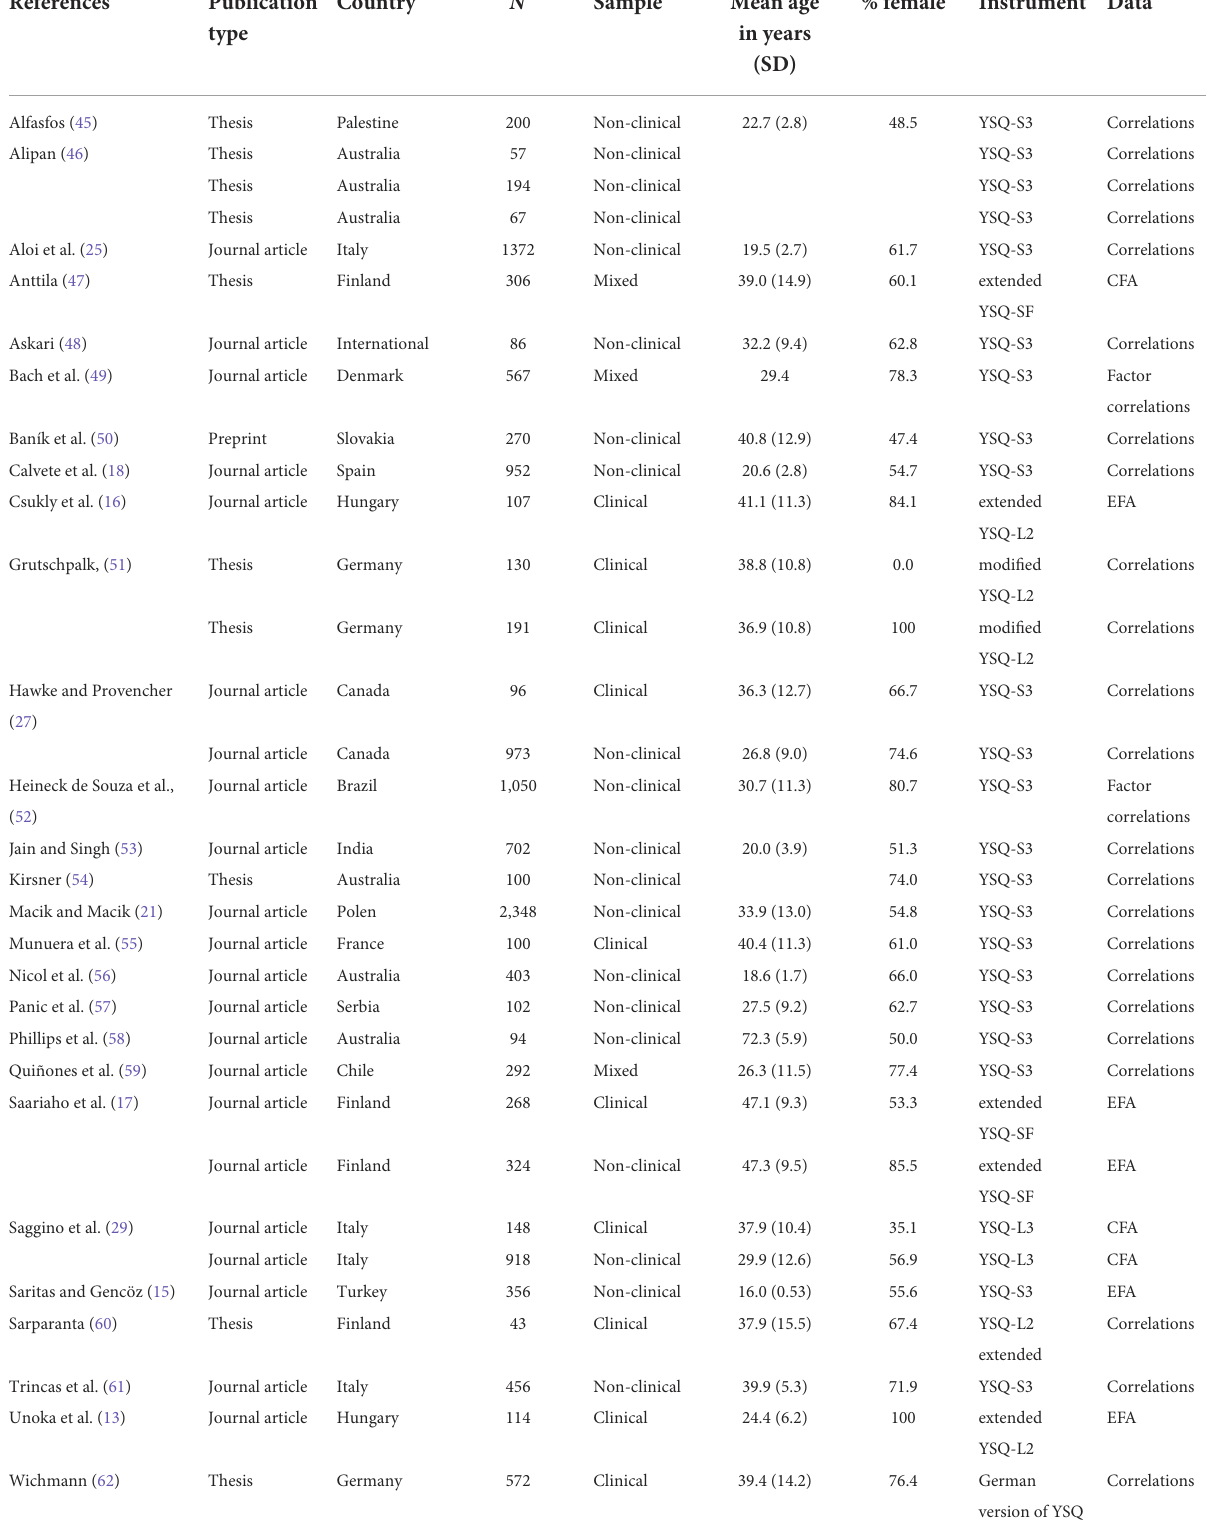
TABLE 2 Characteristics of the samples included in the